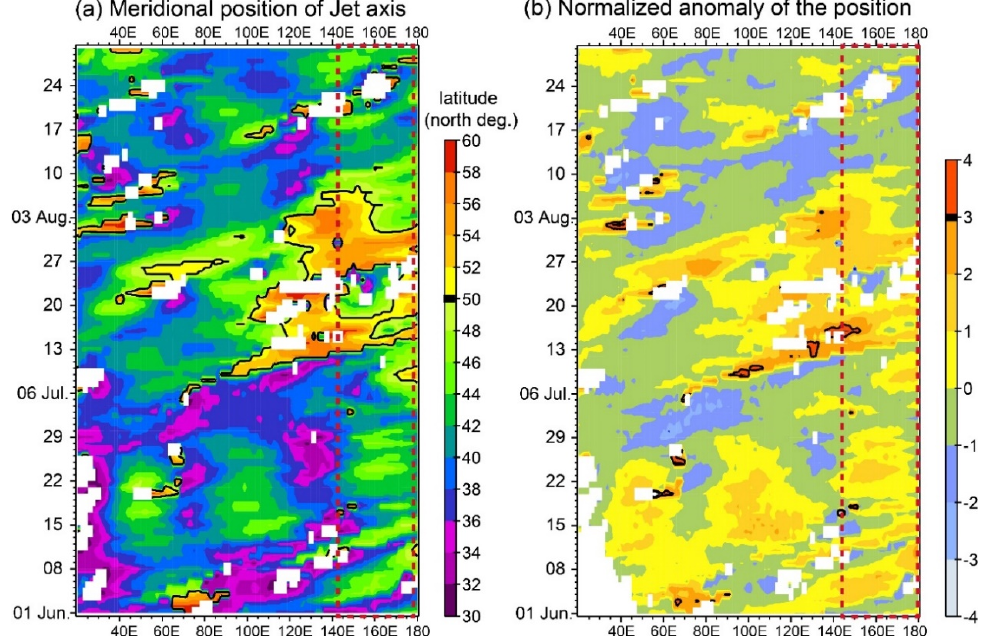
Figure 9. ( a ) Daily meridional position of the westerly jet axis during June–August 2021. The jet axis was defined as the velocity maximum at 200 hPa between 30 ◦ N and 60 ◦ N. When the velocity maximum was at either 30 ◦ N or 60 ◦ N, the axis position was not specified (i.e., white areas). ( b ) Normalized anomalies of the axis position. The daily mean axis position ( Y ) was normalized by the 30-year daily mean ( M ) and the standard deviation ( S ): i.e., ( Y – M )/ S . The values of 50 ◦ N in panel ( a ) and 3 in panel ( b ) are emphasized by bold contours. The red dashed rectangle denotes the area within 143 ◦ E–180 ◦